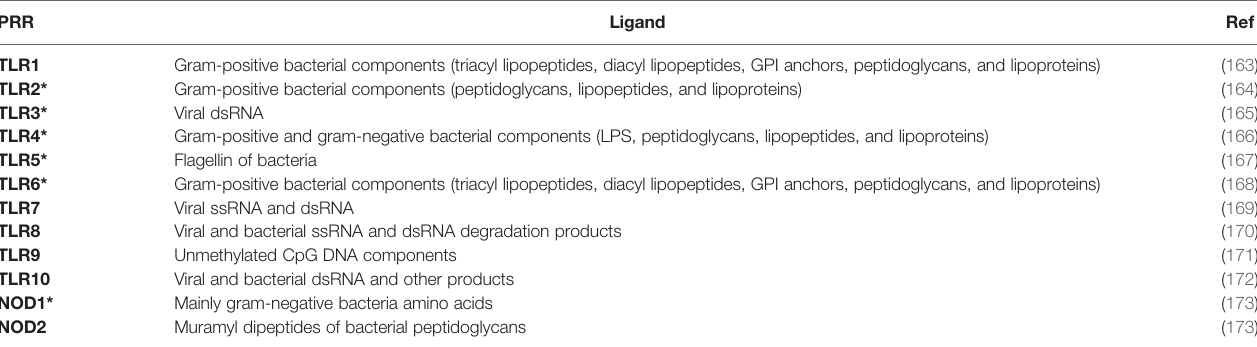
Muramyl dipeptides of bacterial peptidoglycans * Indicates expression by SC